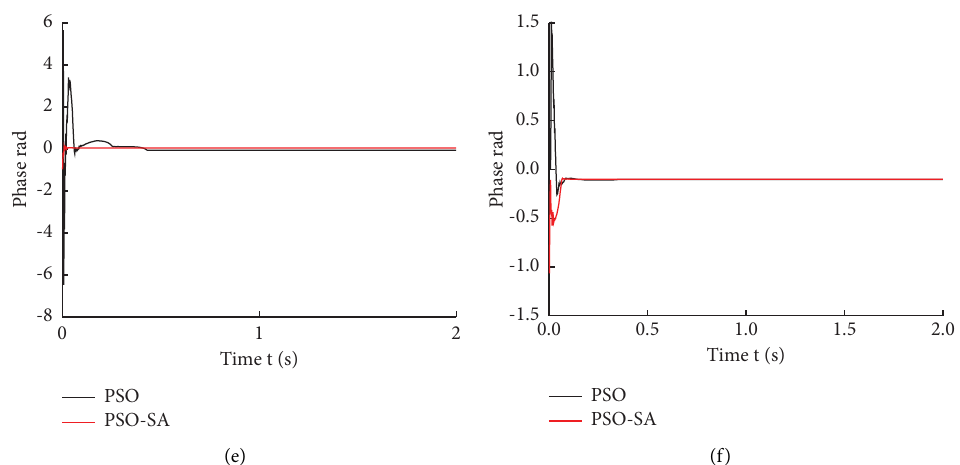
Figure 6: Phase curves of each degree detected based on PSO-SA and PSO algorithm: (a) fundamental wave, (b) second harmonic, (c) third harmonic, (d) fourth harmonic, (e) ffth harmonic, and (f) sixth